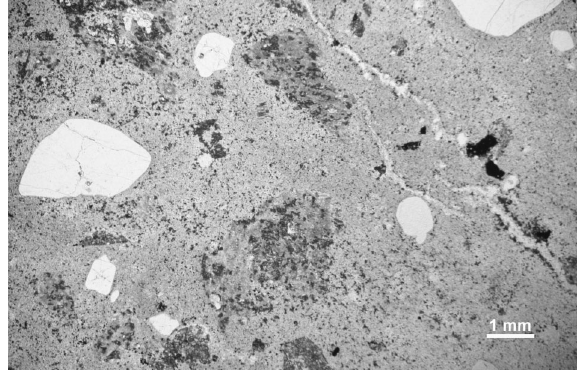
Fig. 3. Suursaari quartz porphyry: quartz and turbid orthoclase phenocrysts in submicroscopic groundmass. Thin-section, back- scattered image. Sample S-32, M(cid:228)kiinp(cid:228)(cid:228)llys.